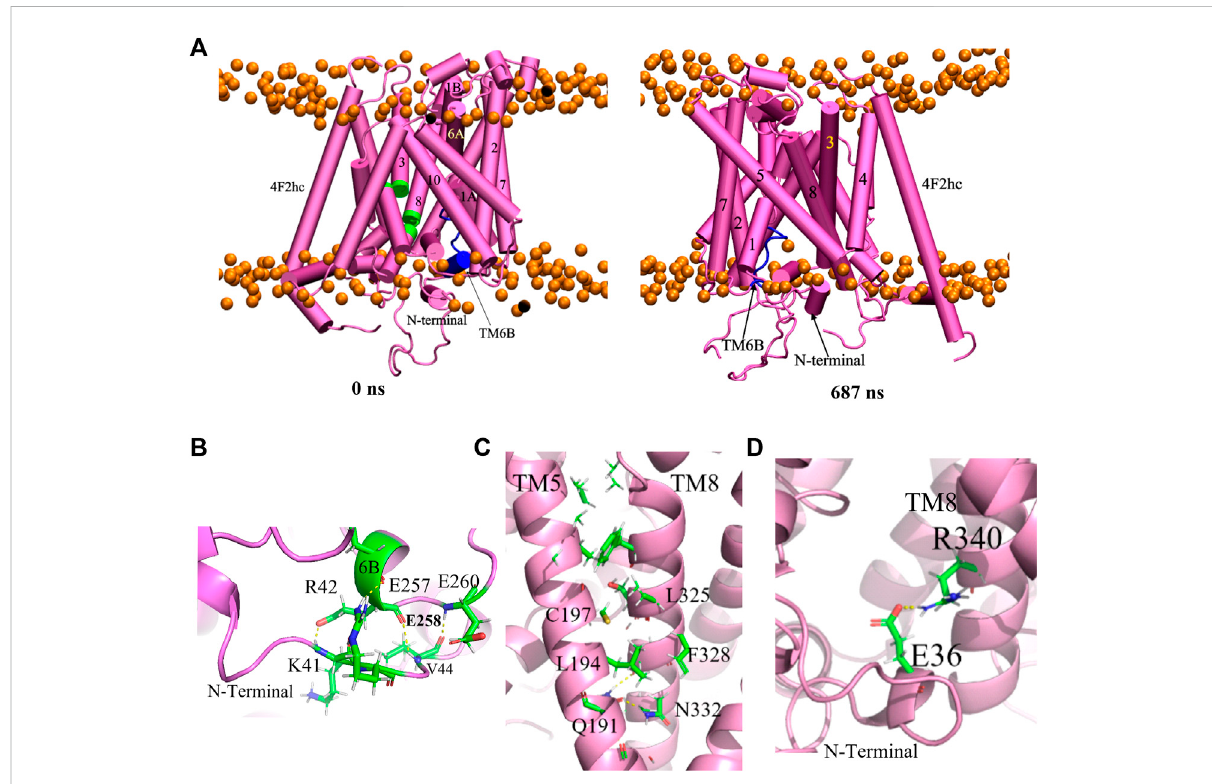
FIGURE 7 (A) Reference structure at 0 ns and representative equilibrium conformation at 687 ns of inward-occluded Sx c − structure in membrane. TM6B and loops of TM3 and TM8 are labelled by the blue and green, respectively. The intracellular surface is at the bottom. A close-up view of (B) the interaction of TM6 and N-terminal region (C) the interaction of TM5 and TM8 and (D) N-terminal helix with